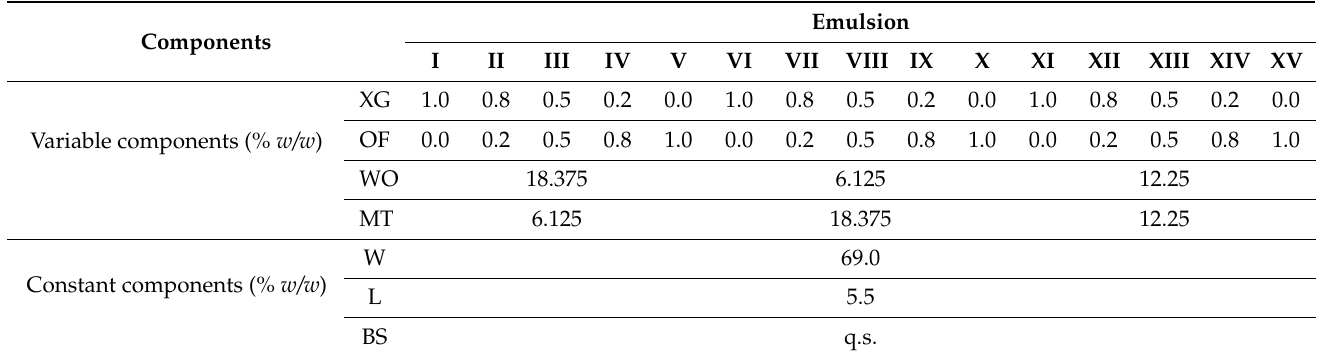
Table 5. Emulsions’